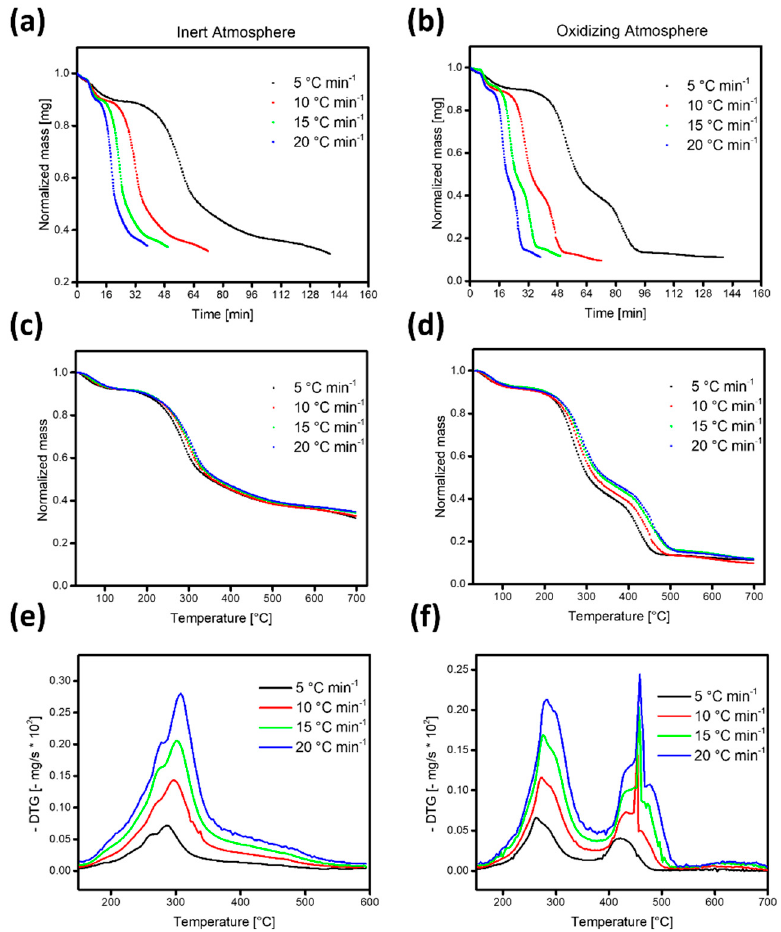
Figure 1. Thermal decomposition of cocoa shells in TG using different atmospheres and heating rates. ( a , c ) inert atmosphere; ( b , d ) oxidizing atmosphere. DTG curves ( e ) inert atmosphere; ( f ) oxi- dizing atmosphere.